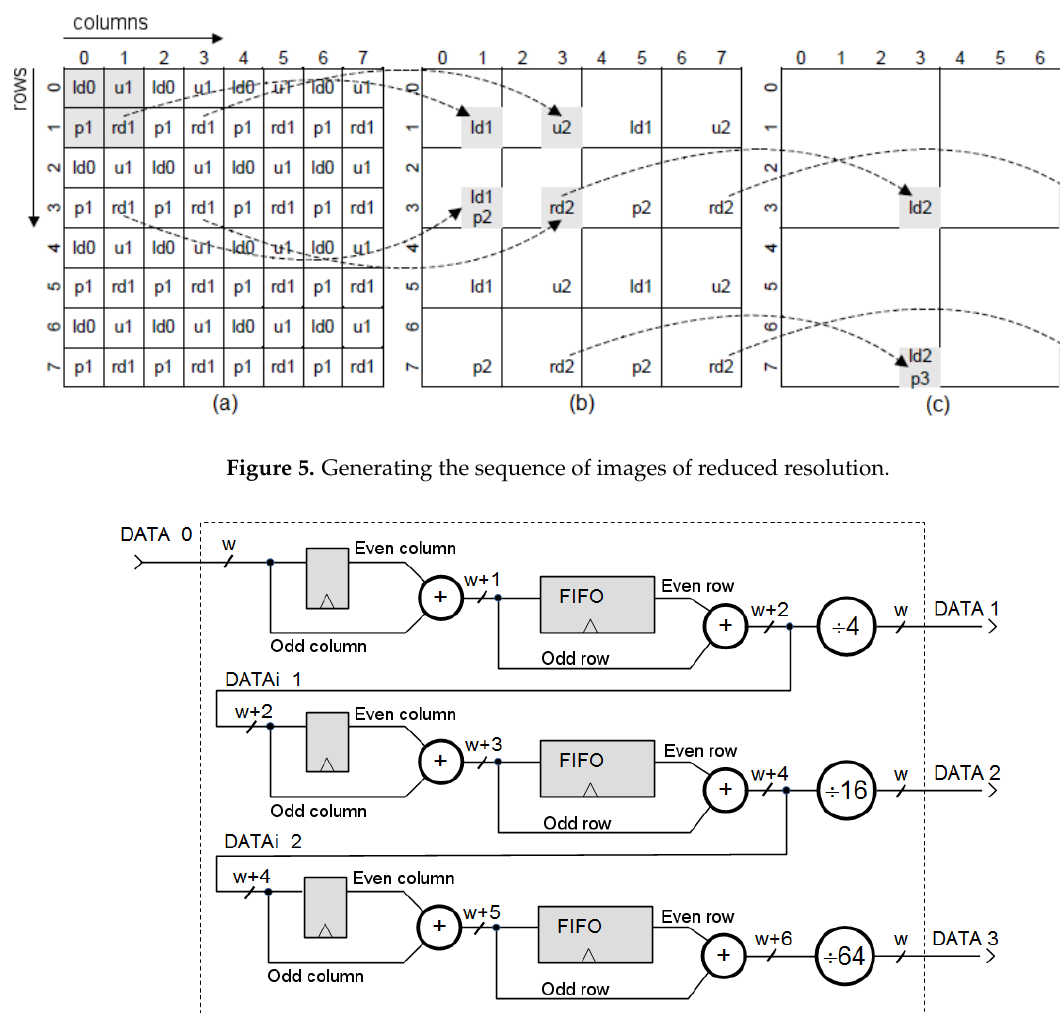
Figure 6. Complete structure of the datapath for generating the first three levels using data from the input image (DATA